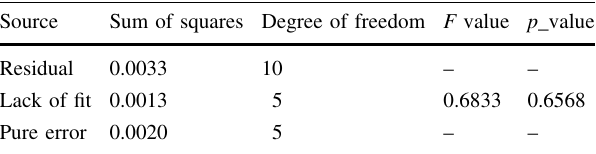
Table 4 Analysis of variance (ANOVA) to determine the suitability of the developed quadratic model in fitting the experimental data